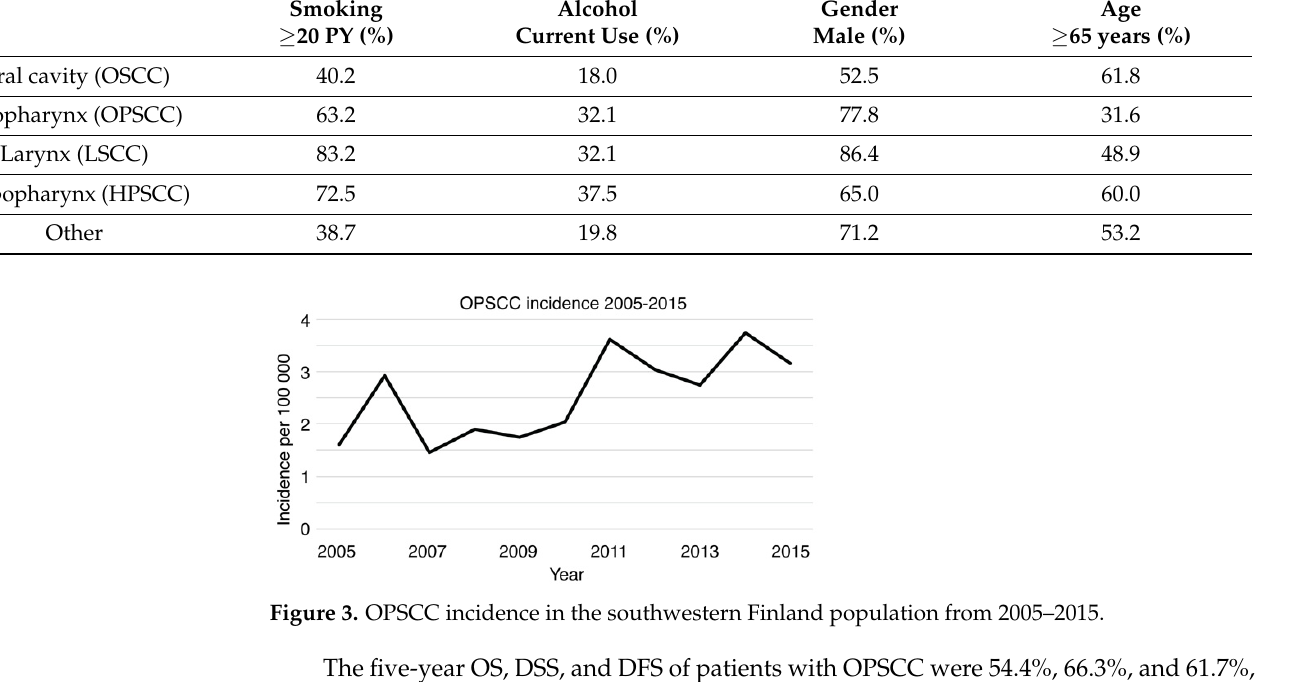
Table 2. Presence of known risk factors in different tumor sites of the head and neck region. Pack year (PY). Alcohol use was defined as 10 doses or more per week at the time of diagnosis. Smoking